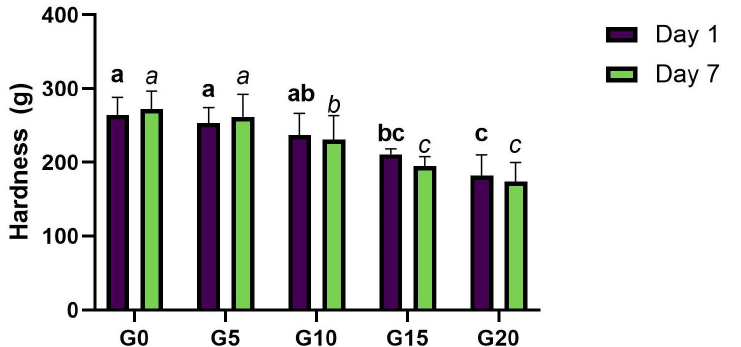
Figure 5. Hardness of fermented PPI gels after 1 and 7 days of storage under refrigeration at 5 °C. Sample name corresponds to its oil content, e.g., G0: 0% oil, G5: 5% oil, etc. Significant differences between samples were highlighted by different letters within day 1 (bold) and day 7 (italics), respectively.